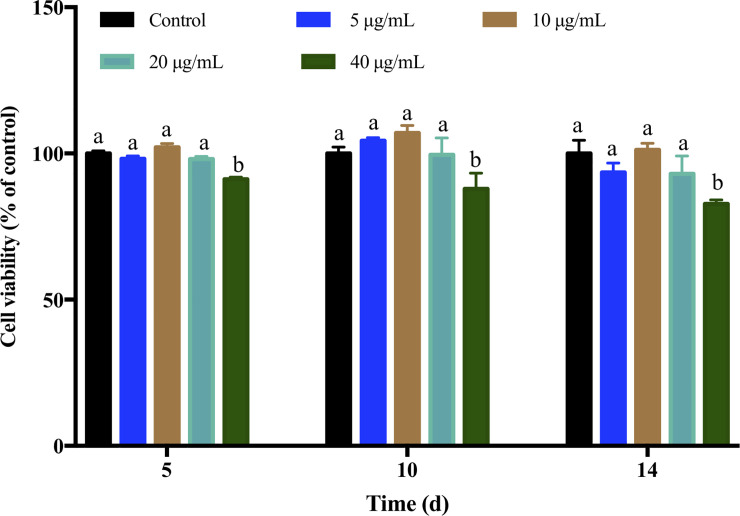
Effect of V-P complex on the cell viability.a, b Different letters indicate a significant difference (p< 0.05) within the graph.